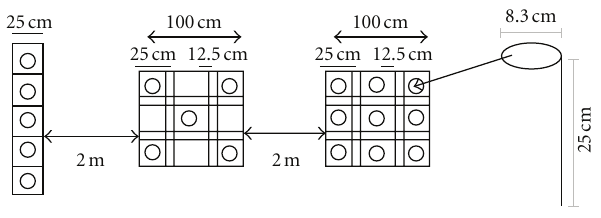
Figure 1: Experimental layout of plug removal to test donor meadow recovery for three treatments: “line 5”, “block 5”, and “block 9”, with schematic view of marker rings (8.3 diameter equals the diameter of the corer) which were placed in the core extraction holes to monitor shoot regrowth into